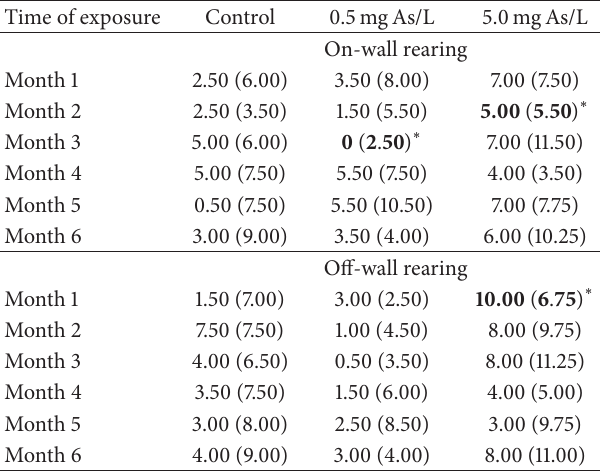
Table 2: On- and off-wall rearing behavior. Table 3: Aggression test (intruder-resident